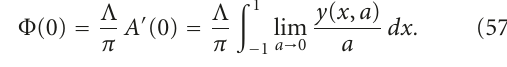
outside the circle, we have neglected the equal flow from in- side sources to outside, and this has to be compensated for by another factor of 2. For areas A 2 and A 3 , this further doubling is not needed, since the source point is let to be located at any point outside the circle, also in these